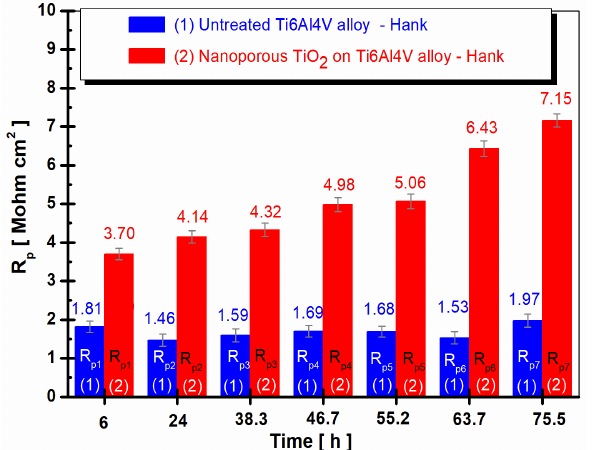
Figure 9. Comparative evolution of the average values of polarization resistance during the 75.5 h immersion period in Hank’s biological solution: (1) untreated Ti6Al4V grade 5 alloy and (2) the treated Ti6Al4V grade 5 alloy with an electrochemically nanoporous titanium oxide surface film.